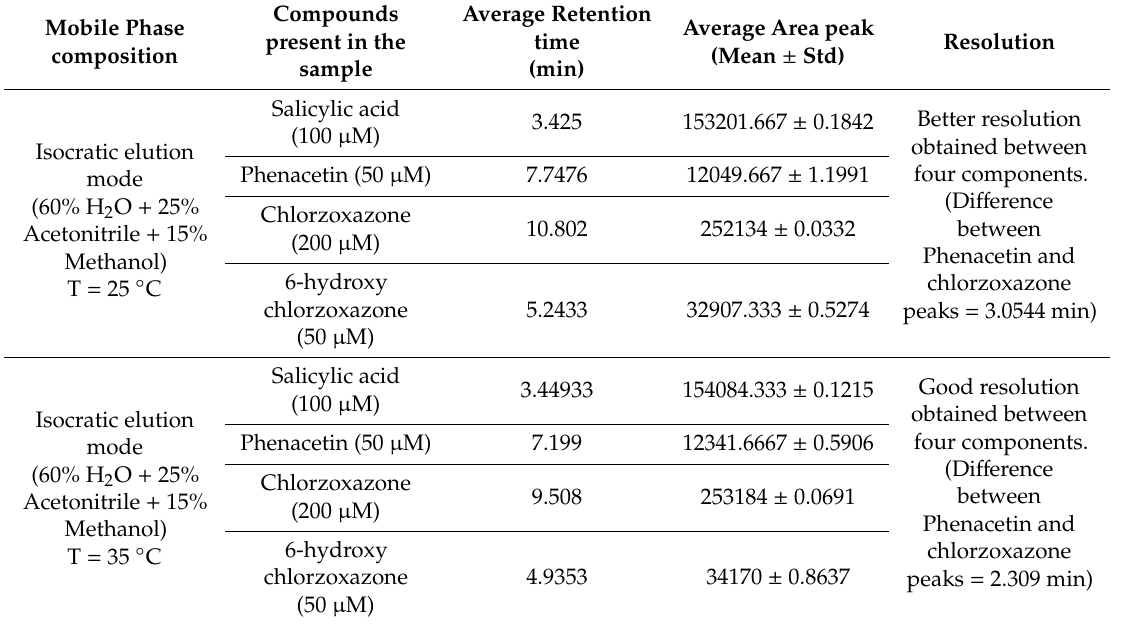
Table A6. Variation in area peak, retention time of each CYP2E1 compounds when changing the column